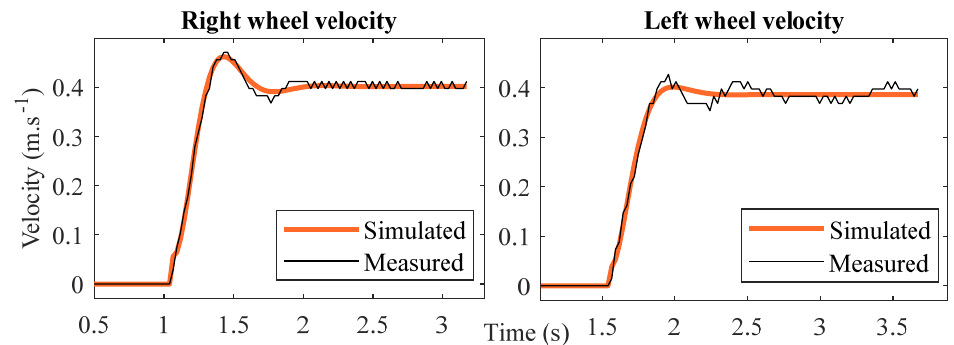
Figure 4. Comparison of measured and simulated velocities of right and left wheel.